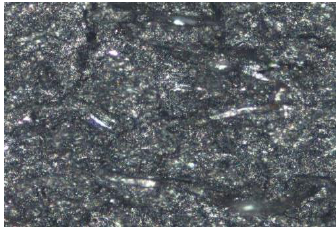
Fig. 4. Microscope image (magnification 100×, reflected light) of the sediment on the outside the mushroom of valve EGR